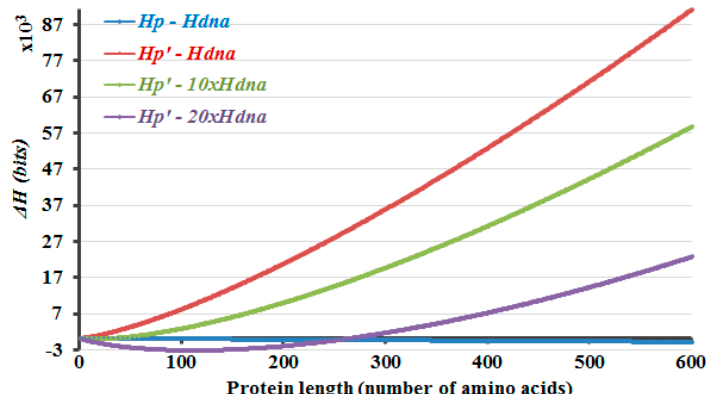
Figure 1. Protein length versus ∆ H values under the condition that the exponent m in the calculations is 1/3, wherever used. ∆ H calculation is done individually by using the Hp calculation in Equation (2) (blue curve), by using the Hp ′ calculation in Equation (4) (red curve), and by using the Hp ′ calculation in Equation (4) together with the additional consideration of the presence of about 9% (green curve) and 5% (purple curve) exons, sequentially, in separate calculations. It is observed that the ∆ H values that are calculated by taking the difference of Hp and Hdna (blue curve) decrease and become more negative, as the protein length increases. This decline is prevented by introducing a protein-length dependent parameter in the calculations, as described in the methods section (red curve). The minimum non-negative ∆ H value relates to the equalization of the information amounts in the protein and the corresponding size of the DNA molecule. It is observed only at around certain length ranges of the protein and the DNA molecules, in case of each ∆ H curve in the figure. This problem is overcome by the implementation of the presence of introns in the calculations of ∆ H . The presence of introns is included in the ∆ H calculations, by means of using a multiplication factor A for the Hdna term that is subtracted from Hp ′ . This varies the protein and the corresponding DNA lengths, where the equalization of the information amounts is observed. This multiplication factor A is 10 (green curve) and 20 (purple curve) in case of the graphs that are shown in the figure.